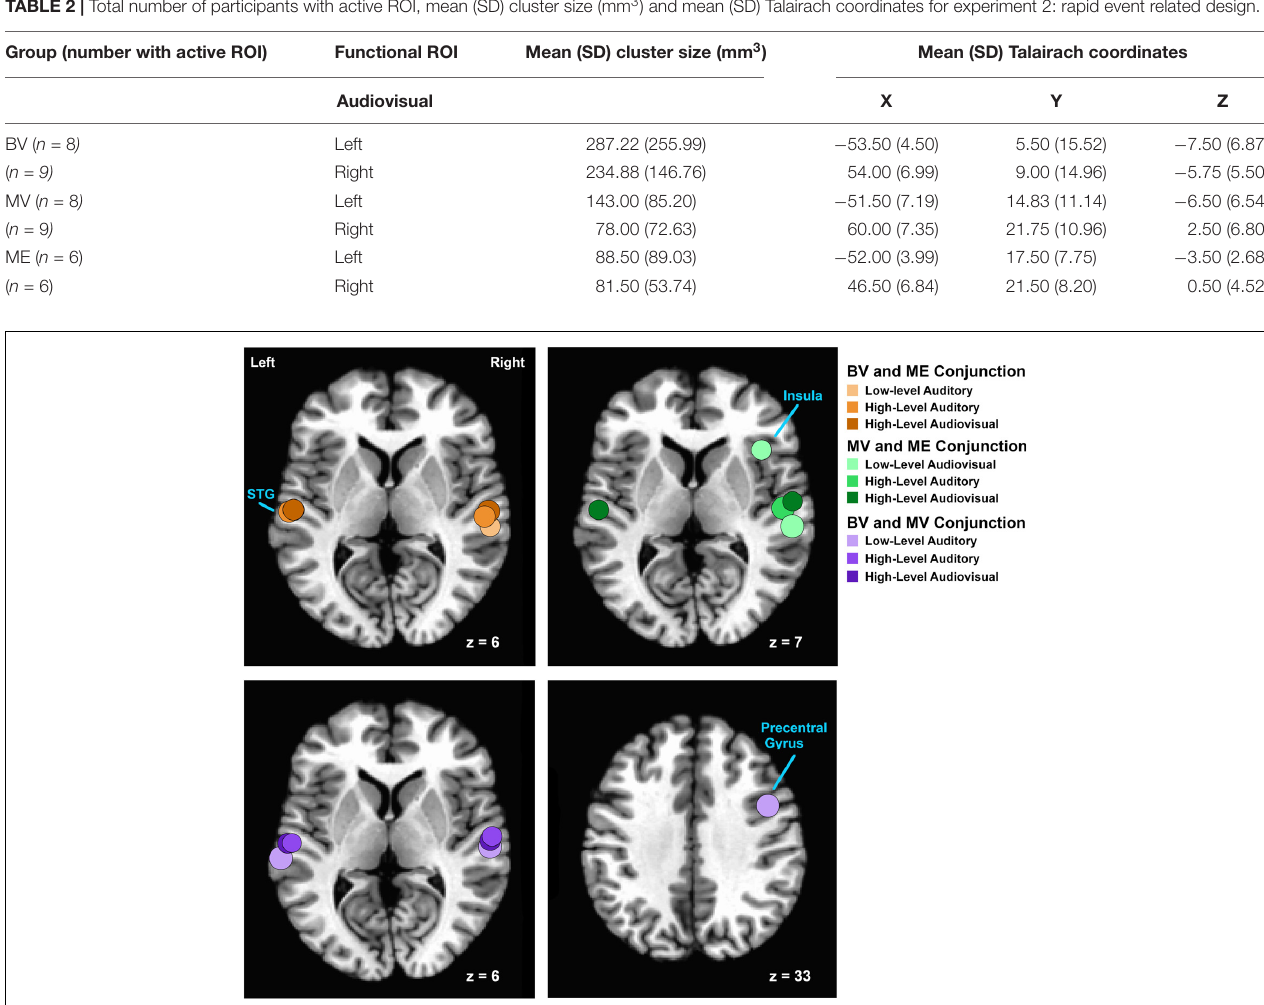
FIGURE 3 | Relative locations of areas isolated using conjunction analyses of functional activation for auditory, visual and audiovisual stimuli between groups. Regions are plotted as spheres (radius = 6 mm) centerd on the mean Talairach coordinates for each pair of groups. Overlapping areas of functional activation for the conjunction analysis between BV and ME groups are shown on an axial slice at Talairach z = 6 in shades of orange. Overlapping areas of functional activation for the conjunction analysis between MV and ME groups are shown on an axial slice at Talairach z = 7 in shades of green. Overlapping areas of functional activation for the conjunction analysis between BV and MV groups are shown on an axial slice at Talairach z = 6 and z = 33) in shades of purple.